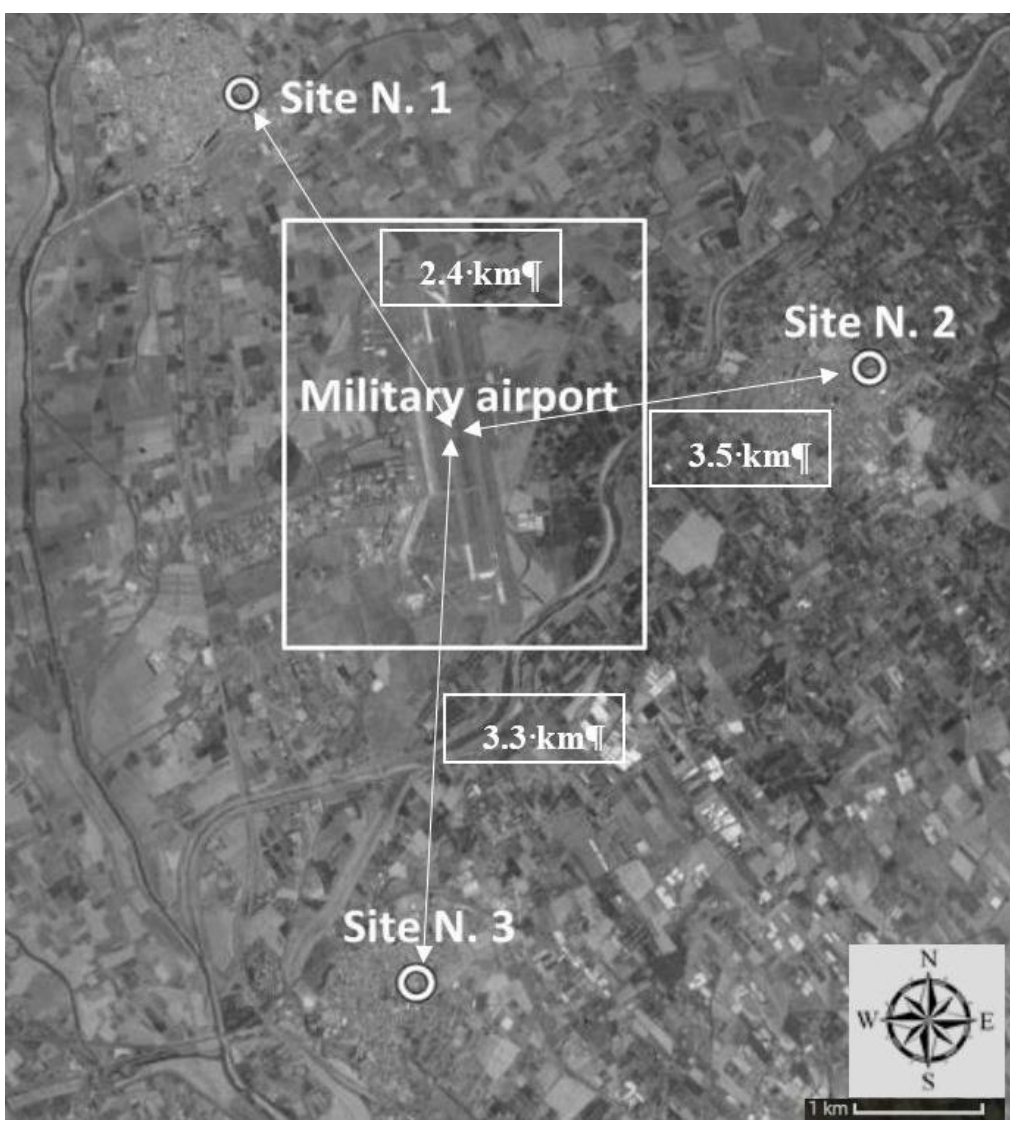
Figure 1. Site N. 1, Site N. 2, and Site N. 3, nearby the military airport.